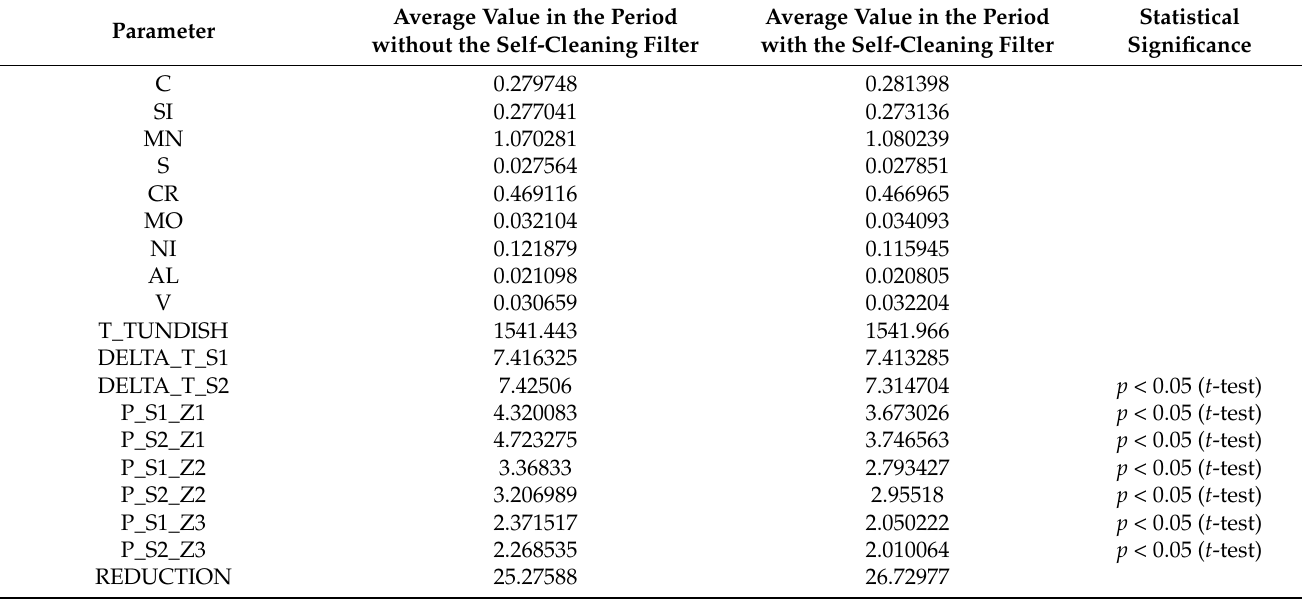
Table 4. The parameters’ comparison between the period without the self-cleaning filter (713 cases) and with the self-cleaning filter installed for the cooling water of the secondary cooling of the continuous caster (794 cases). Average Value in the Period Average Value in the Period Parameter without the Self-Cleaning Filter with the Self-Cleaning Filter